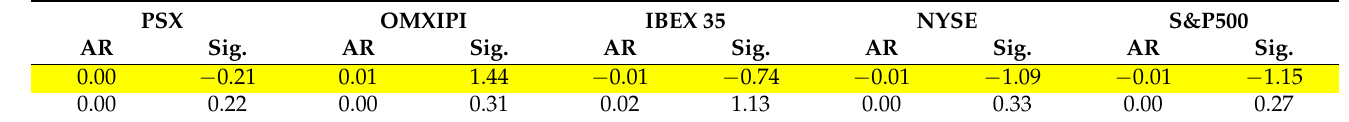
Table A28. Abnormal returns of the (0, +1) event window (Jurgen Mossack Resignation).